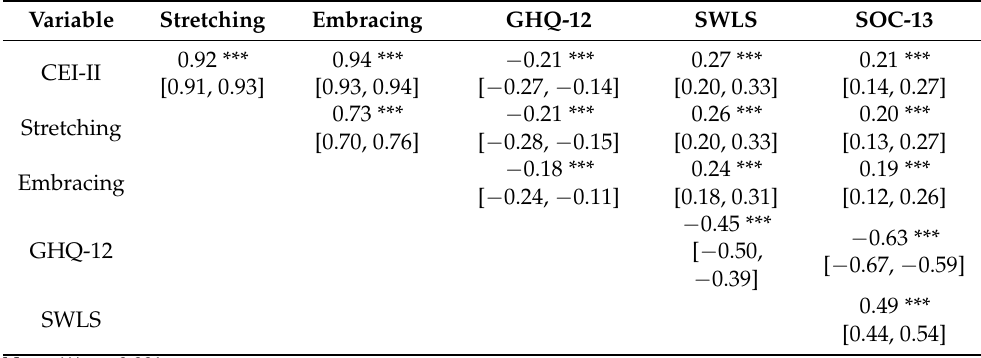
Table 6. Correlations between CEI-II scores (scale and subscales) and other variables.